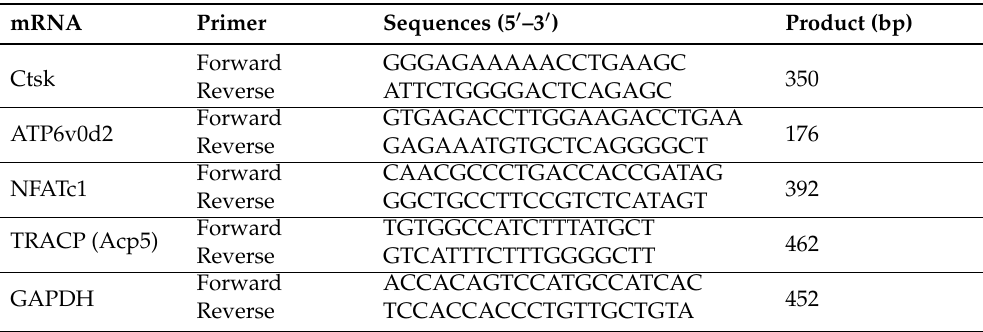
Table 1. List of primers used for